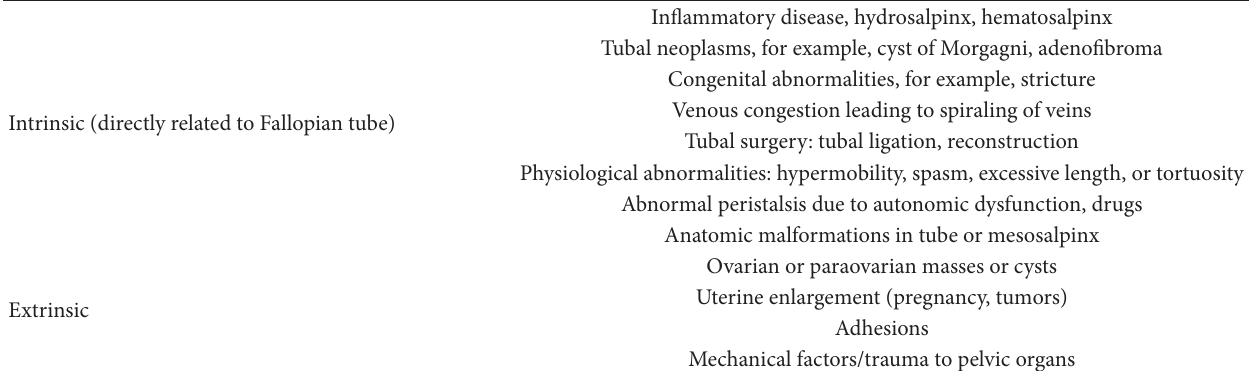
Table 1: Fallopian tube torsion: predisposing factors and theories for etiology [7,